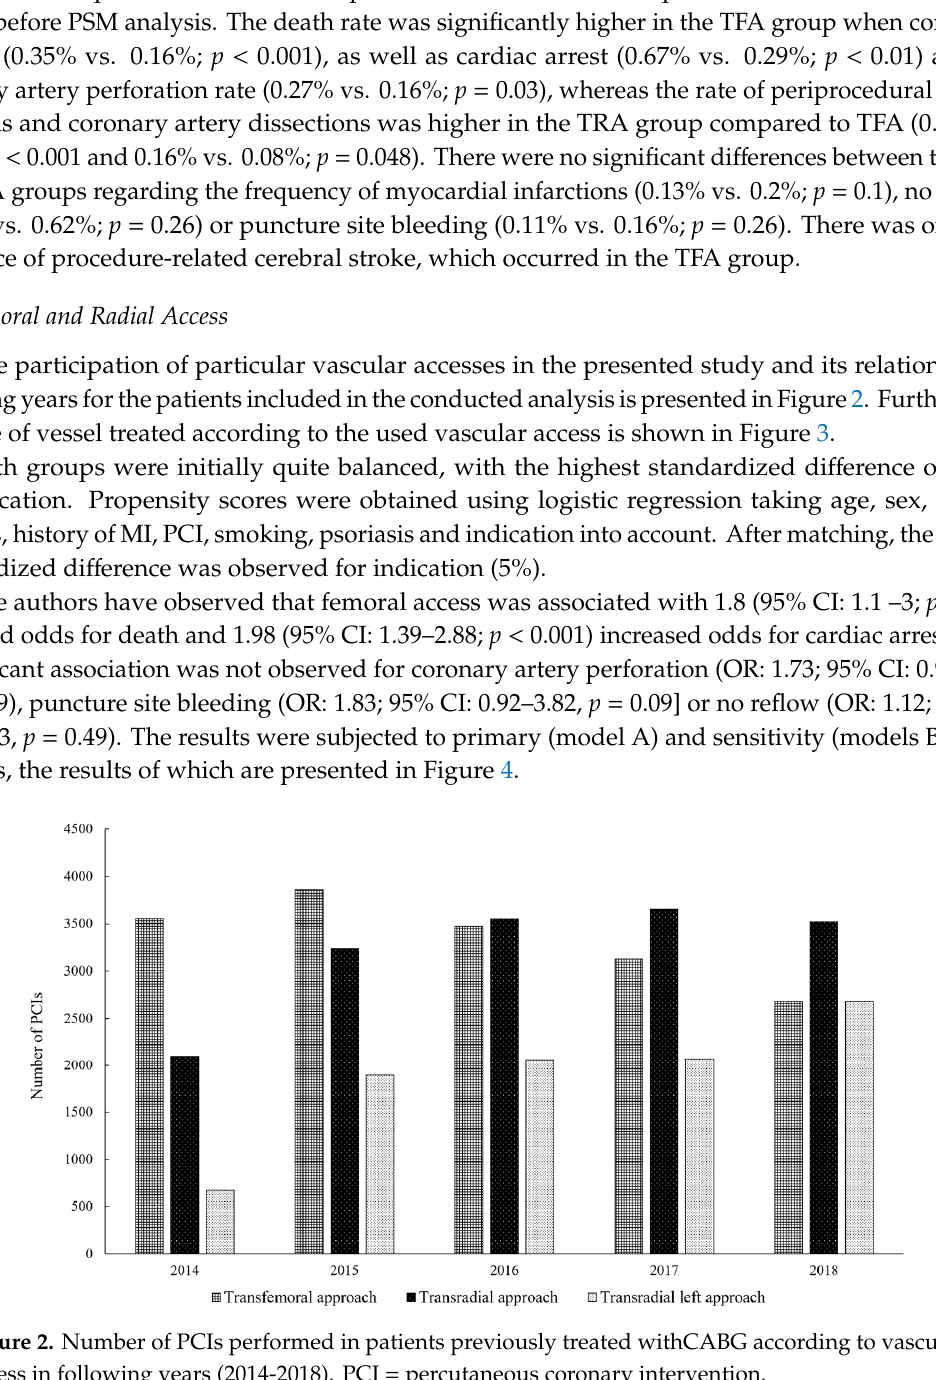
Figure 3. Percentage of PCIs performed on individual vessels depending on the type of vascular access in patients after CABG operation and treated with PCI: ( A ) Overall group; ( B ) Femoral approach; ( C ) Radial approach; ( D ) Left radial approach. Cx = circumflex branch; LAD = left anterior descendent branch; LMCA = left main coronary artery; L/RIMA = left/right internal mammary artery; RCA = right coronary artery; SvG = saphenous vein graft.